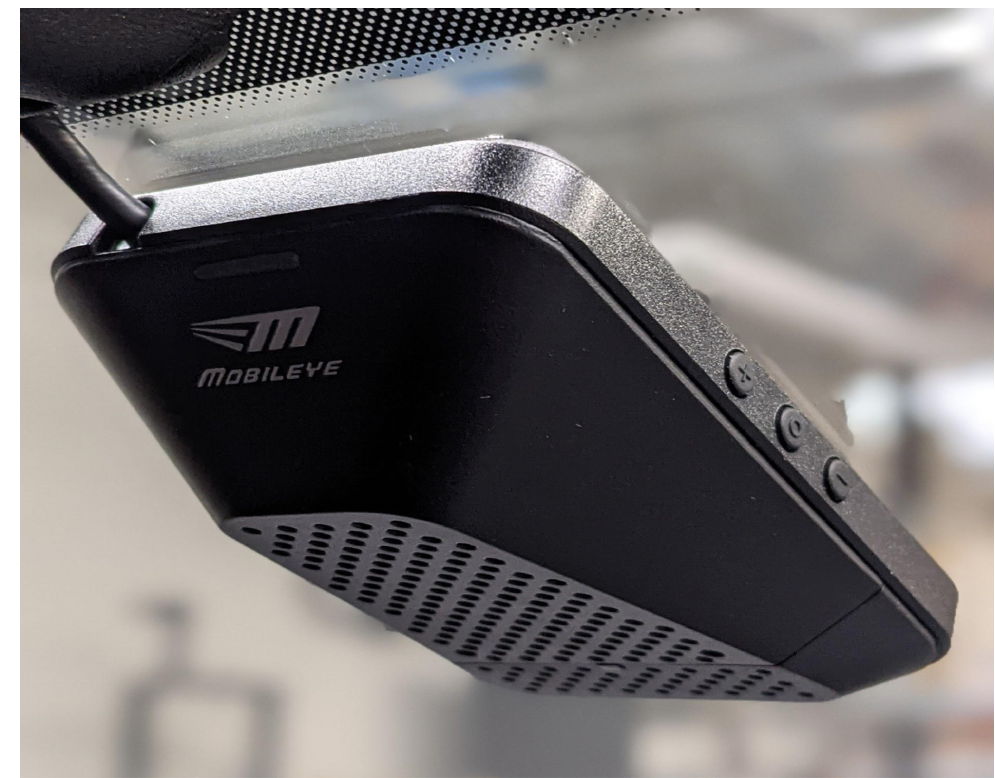
Figure 5. Sensor and hardware placement for autonomous